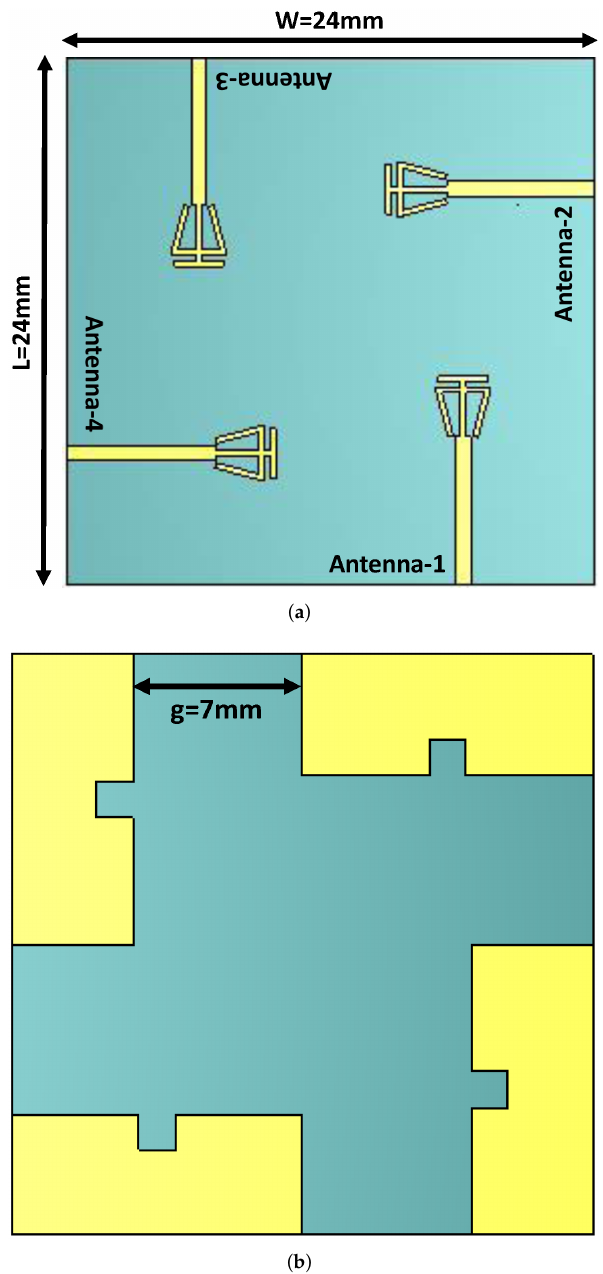
Figure 4. Proposed MIMO antenna ( a ) front-view and ( b )